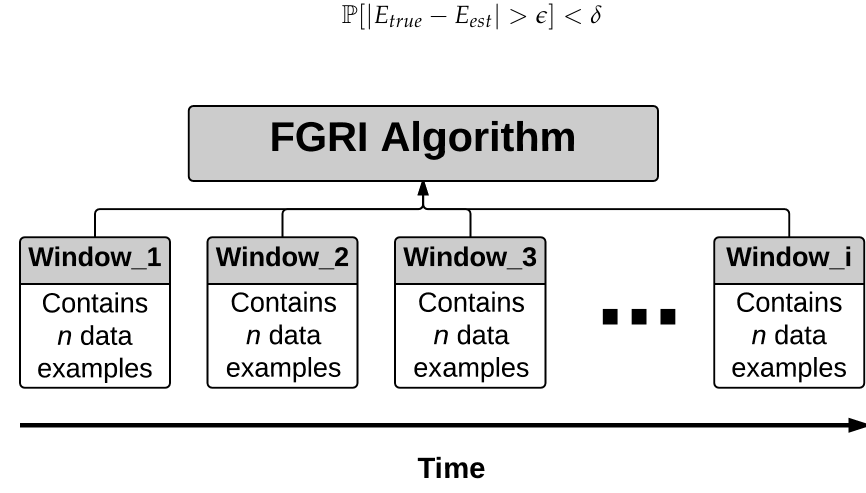
Figure 4. Sliding windows approach to induce rules from streaming